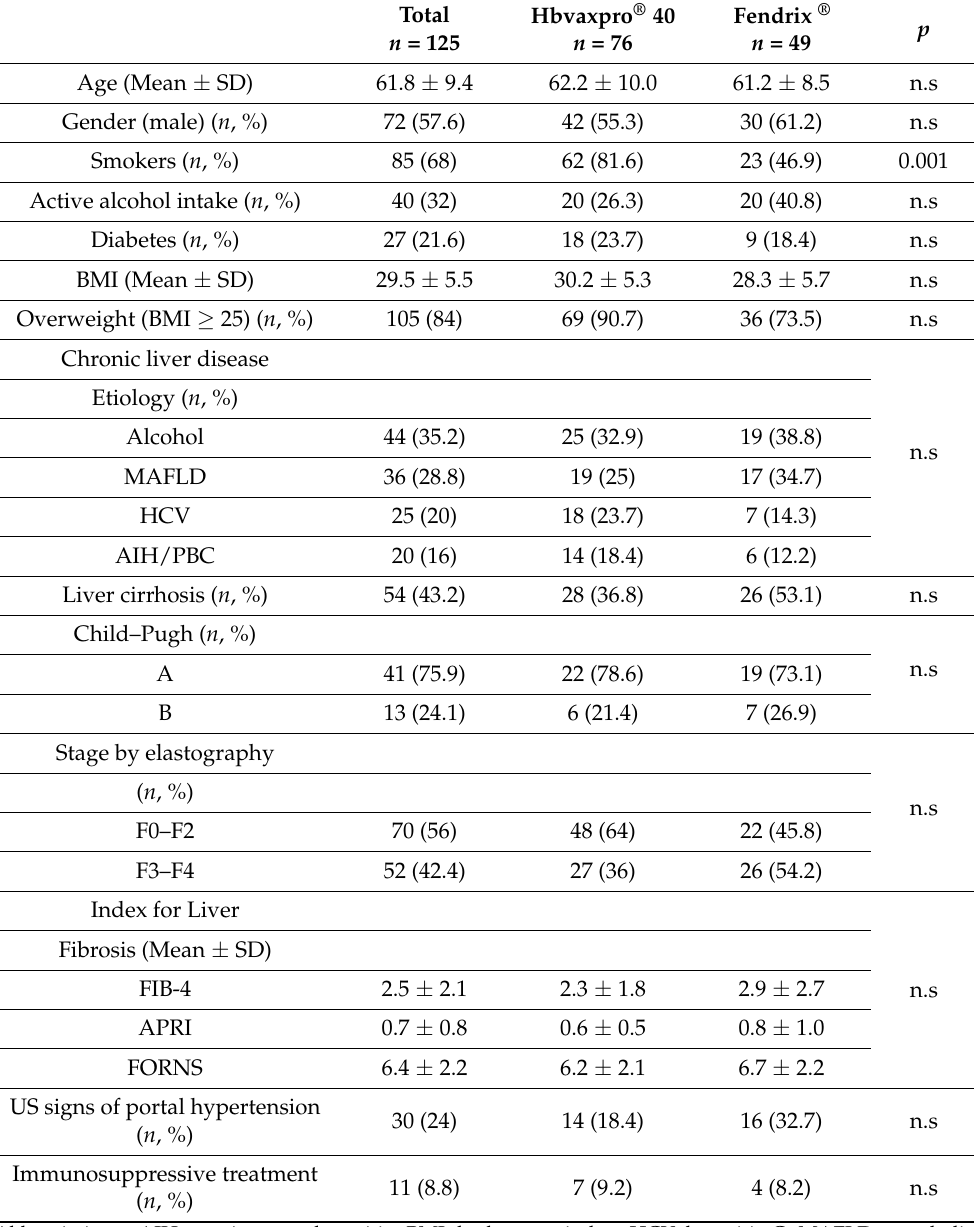
Table 1. Baseline characteristics of patients included in the